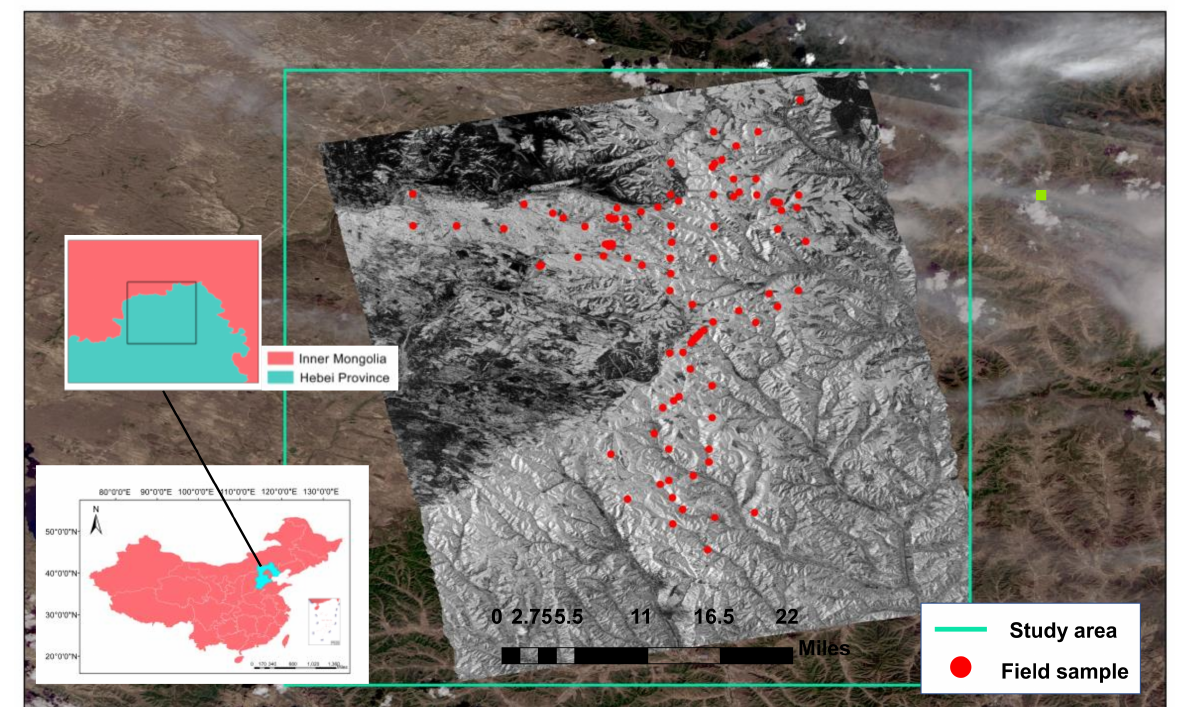
Figure 1. Map of the study area. The area is located in the Saihanba Forest in Hebei Province, China. The red points represent the distribution of the measured samples. The image in the study area is an interferometric image under HV polarization of PolInSAR